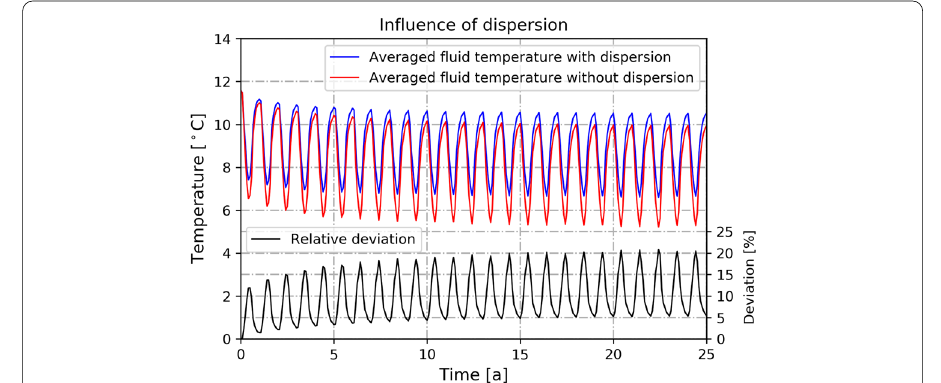
Fig. 10 Comparison of simulation results with and without